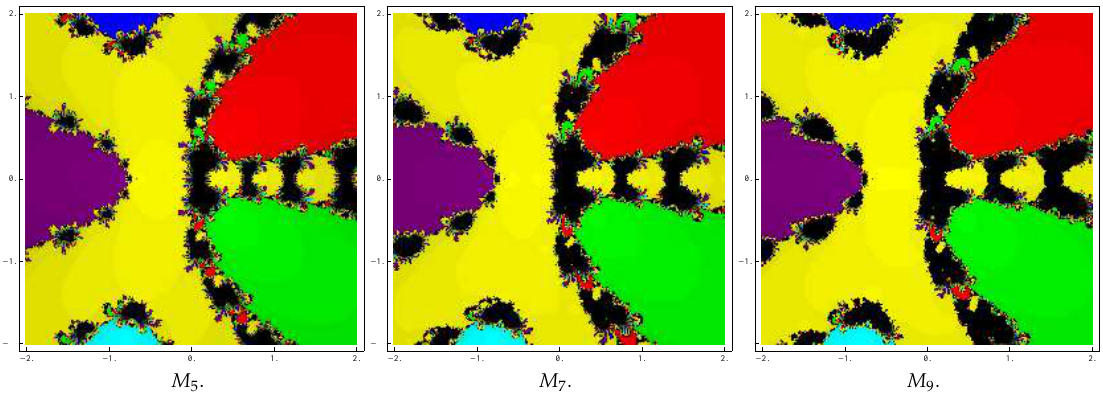
Figure 8. Basins of attraction of M 5 , M 7 , and M 9 for polynomial P 3 ( z )